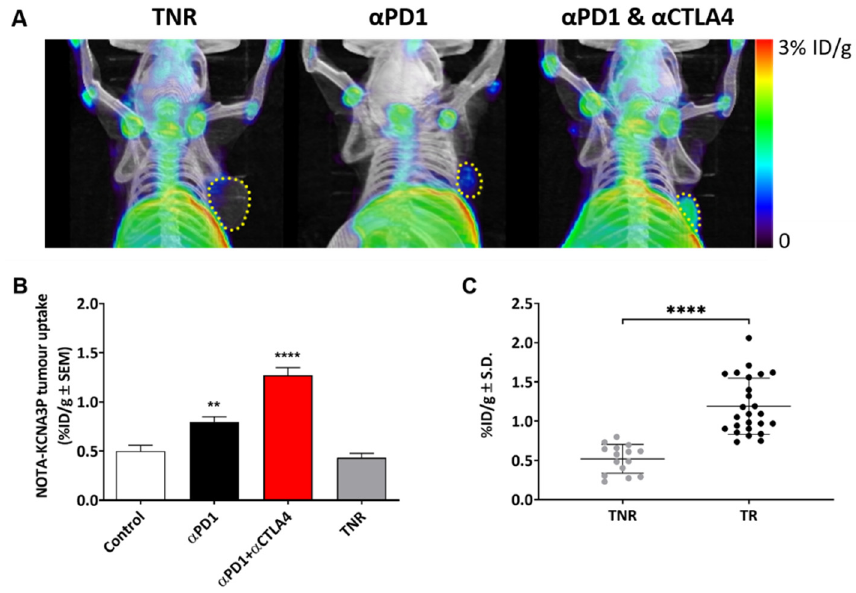
Figure 3. ( A ) Representative maximum intensity projection PET-CT images showing [ 18 F]AlF-NOTA-KCNA3P tumour retention in α PD-1 responders, combined α PD1 + α CTLA4 responders and TNRs. Yellow dashed line indicates tumour boundary. ( B ) [ 18 F]AlF-NOTA-KCNA3P tumour uptake values in each treatment arm; Control, α PD-1 responders and combined α PD1 + α CTLA4 responders compared to treated non-responsive tumours (TNR, n = 10–12 mice/ group; ** p < 0.01, **** p < 0.0001 comparing to TNR; data shown as the mean %ID/g ± S.E.M.). ( C ) [ 18 F]AlF-NOTA-KCNA3P tumour uptake in CT26 TRs and TNRs (**** p < 0.0001, data shown as individual %ID/g).